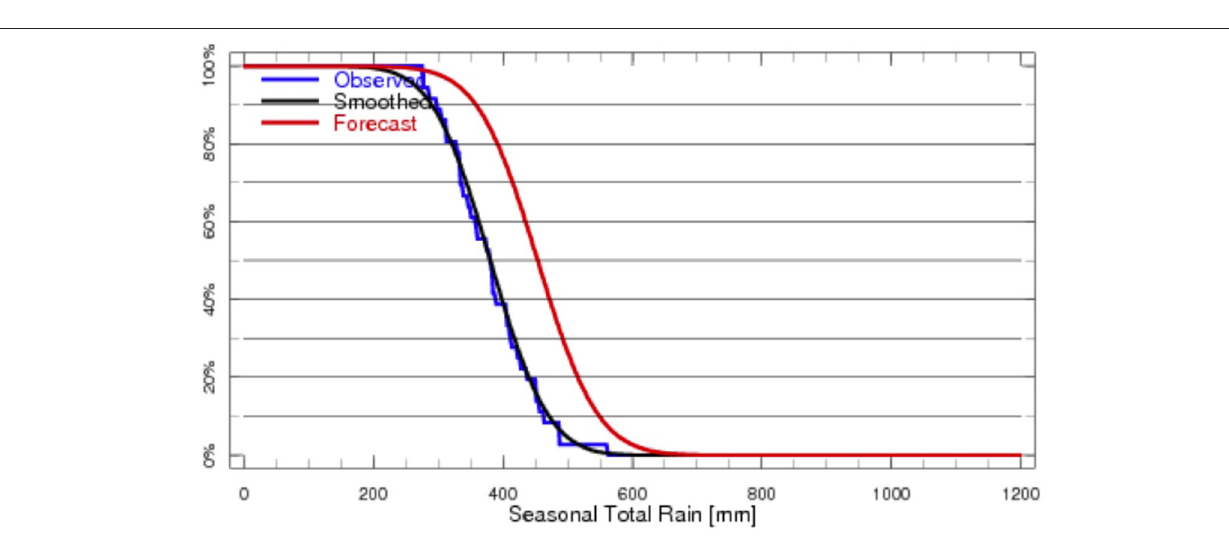
Rwanda with focus on a specific application, and the second is Ethiopia where ENACTS has been supporting climate more